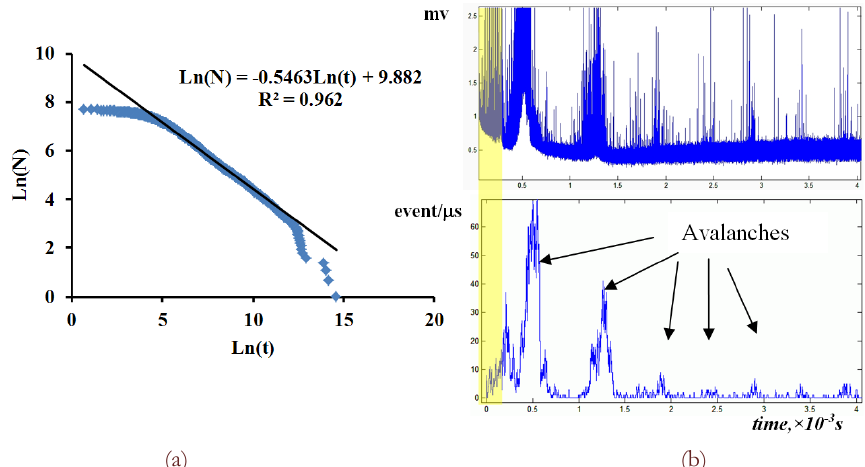
Figure 12: a) Cumulative distribution function of time interval in the double logarithmic plot. b) The signal from the oscilloscope and the frequency of impulse